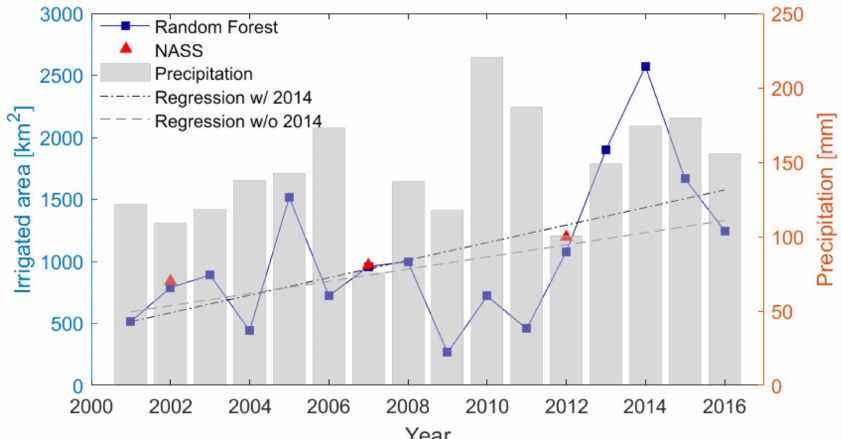
Figure 7. Annual total irrigated area in SW MI according to the random forest-based irrigation maps (line with squares), NASS Consensus (triangles, [2]). Gray bars show precipitation during the 15 June–31 July period, averaged over the study domain. Linear regression with and without 2014 irrigated area is also